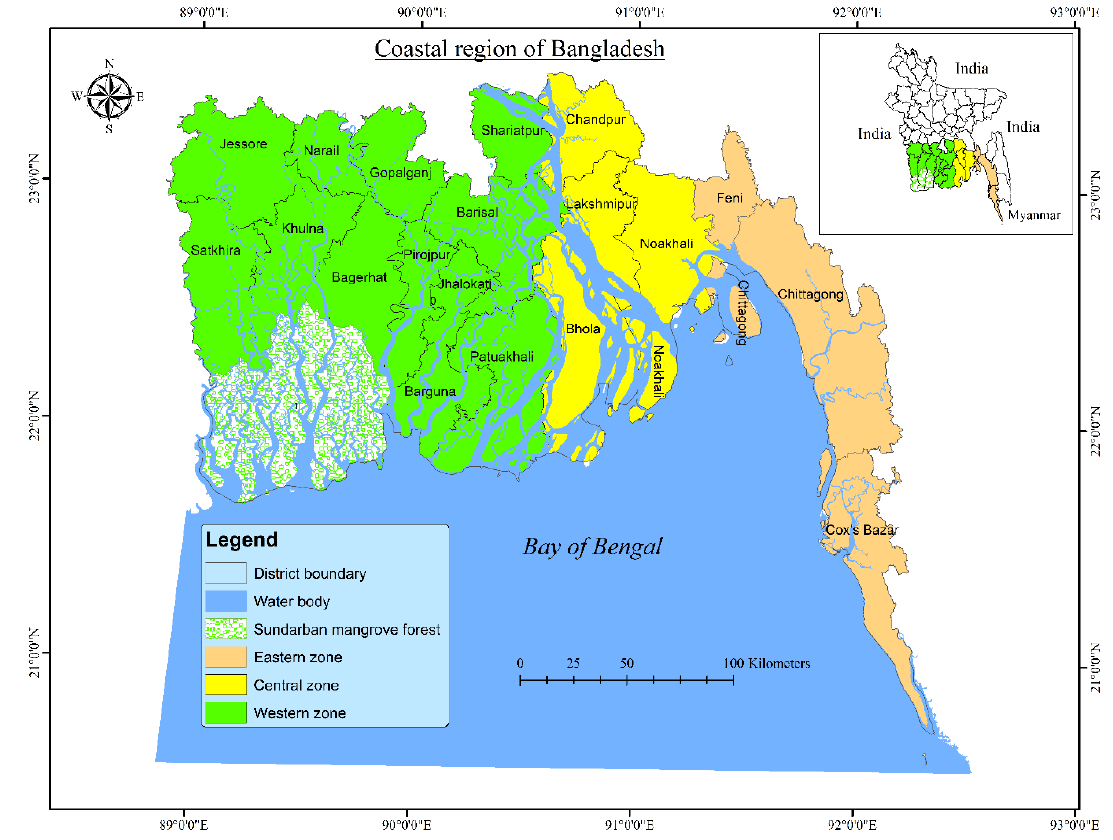
Figure 2. Case study area map showing the entire coastal region of Bangladesh with the di ff erent coastal zones and districts.